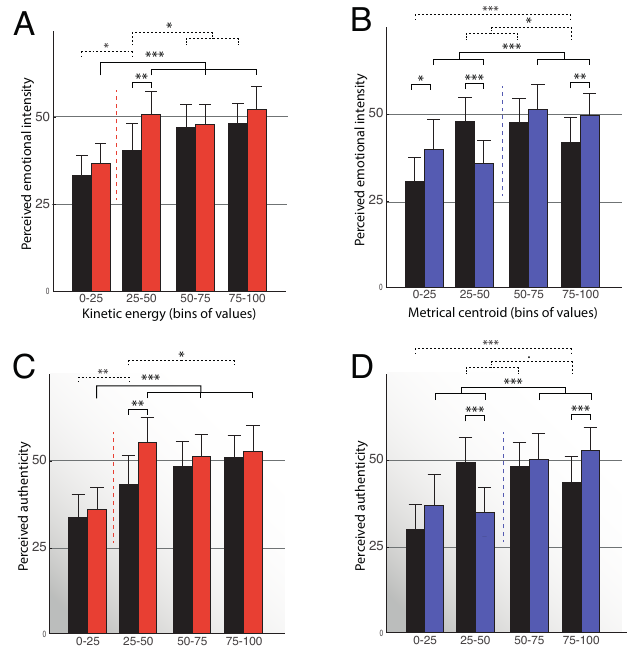
Figure 4. Impact of the interaction of the computed features: ( A , C ) kinetic energy (red); and ( B , D ) metrical centroid (blue); and the presence of an audience on: ( A , B ) the perceived emotional intensity; and ( C , D ) the perceived authenticity (deadpan: DP, projected: PROJ, and exaggerated: EXAG) ( p < 0.01, * p < 0.05, ** p < 0.01, *** p <